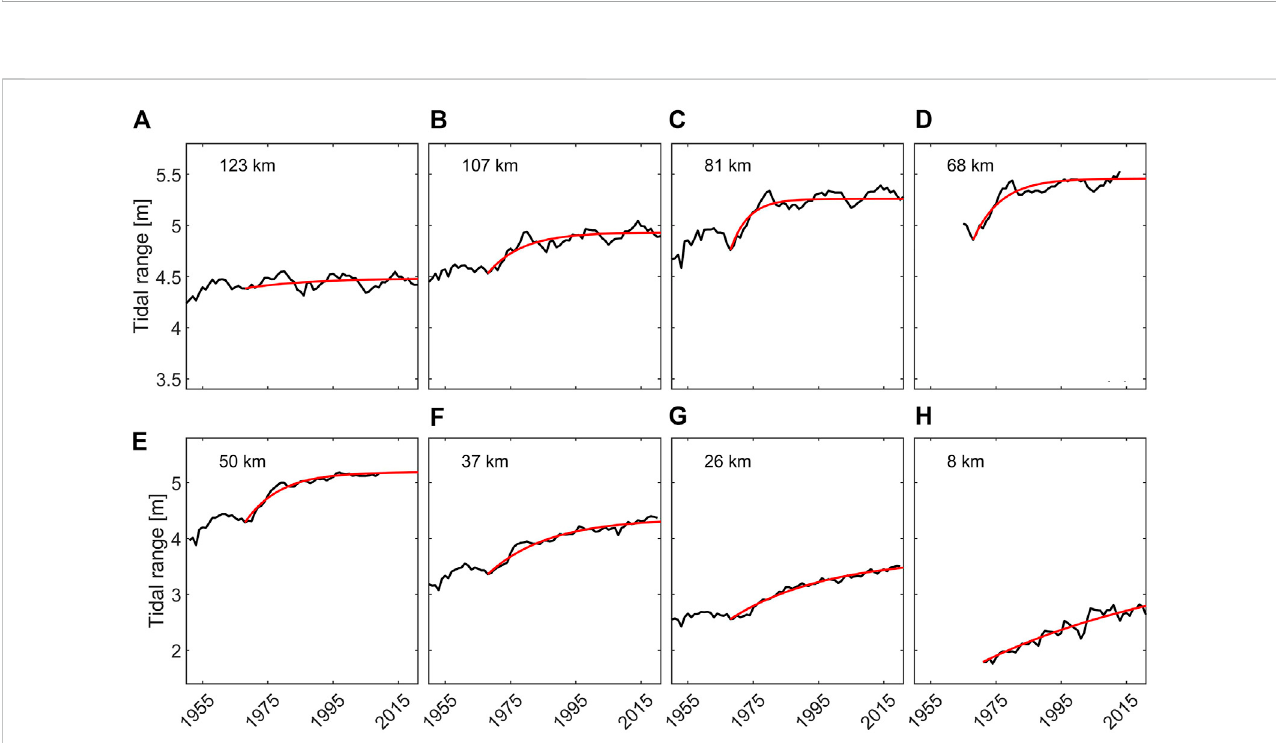
FIGURE 15 Observed(black)increaseintidalrangeAovertime(panel (A – H) ,perstation)fortheScheldtEstuary. Theredlineisa fi